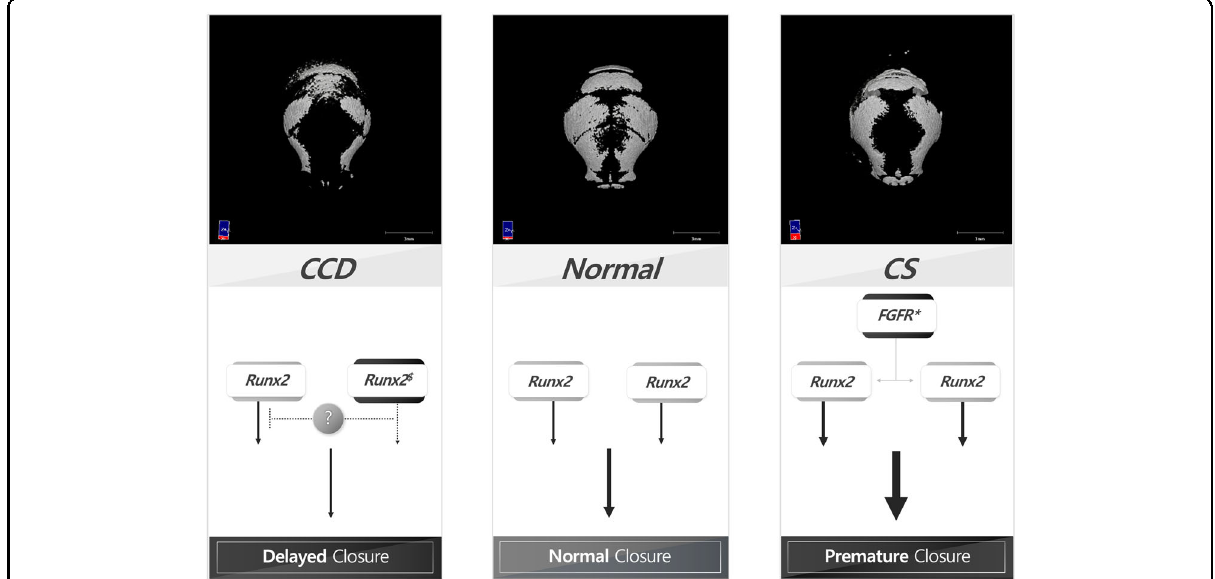
Fig. 1 Hypothesis of the molecular mechanism involving RUNX2 in cranial suture anomalies. RUNX2 transcriptional, translational and PTM level regulations are closely associated with cranial suture anomalies. Based on the amount of RUNX2 expressed in the normal skull, hypoostotic disease, typically CCD, results from a reduced RUNX2 level in the cranial sutures due to haplode fi ciency. In contrast, osteopenic disease, typically CS, results from an increased RUNX2 level in the cranial sutures due to constitutive FGFR2 signaling. (asterisk means hyper-active mutation of gene; $ means hypo-active mutation of